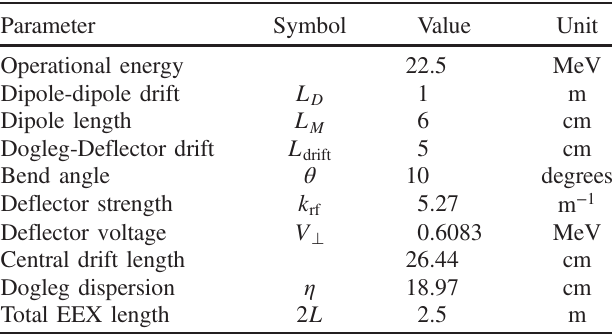
TABLE I. Emittance exchange line parameters.